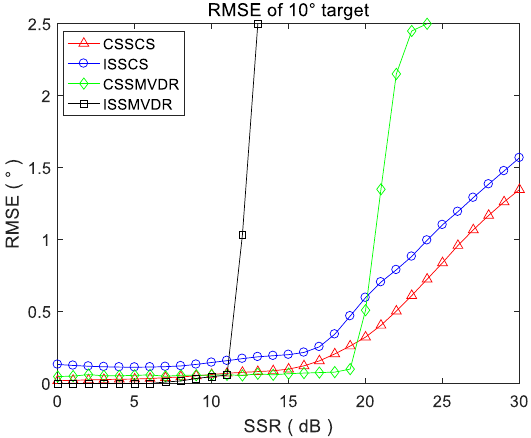
Figure 7. NMSE curves of four methods for DOA estimation of 10° target in terms of SSRs.